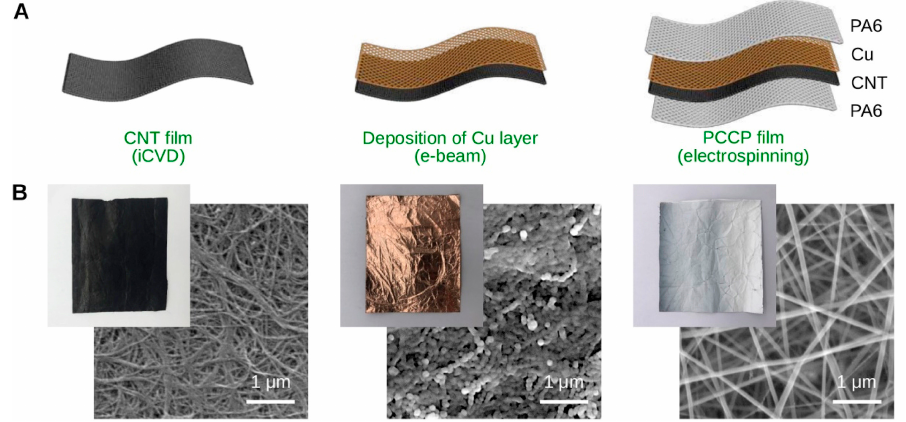
Figure 6. ( A ) Schematic of the fabrication of PCCP composite textile; ( B ) photos (10 cm × 10 cm) and SEM images of the CNT film, Cu layer and PA6 surface of PCCP textile. From [114], copyright (2020), with permission from Elsevier.